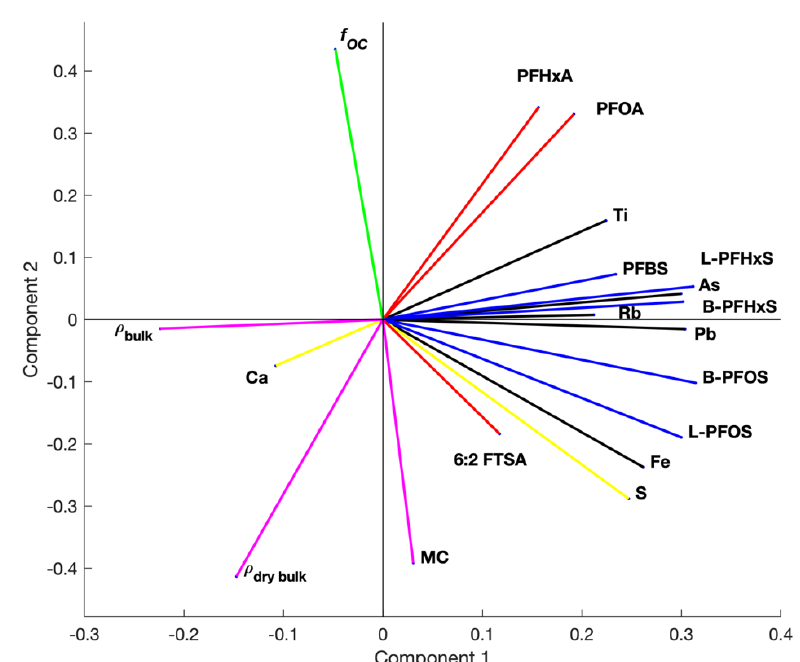
Figure 3. Bi-plot on parameter contribution the data variance within the first (43% explained) and second (24% explained) component spaces, including PFCAs and FTSA (red); PFSAs (blue); sediment iron, lead, rubidium, arsenic and titanium (black); sediment sulfur and calcium (yellow); sediment densities ( ρ dry bulk and ρ bulk ) and moisture content (MC) (magenta); and fraction organic carbon ( f OC , green).